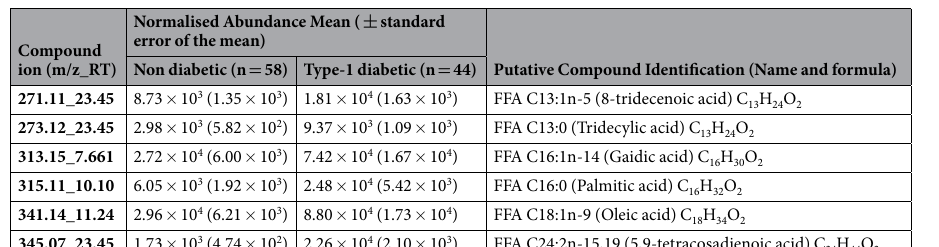
Normalised Abundance Mean ( ± standard error of the mean) Compound ion (m/z_RT) 271.11_23.45 8.73 × 10 3 (1.35 × 10 3 ) 1.81 × 10 4 (1.63 × 10 3 ) FFA C13:1n-5 (8-tridecenoic acid) C 13 H 24 O 2 273.12_23.45 2.98 × 10 3 (5.82 × 10 2 ) 9.37 × 10 3 (1.09 × 10 3 )